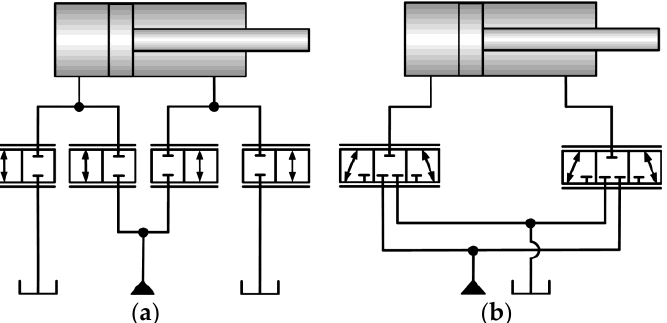
Figure 3. Two typical kinds of hydraulic system layouts. ( a ) Four 2/2-valves ( b ) two 3/3-valves.